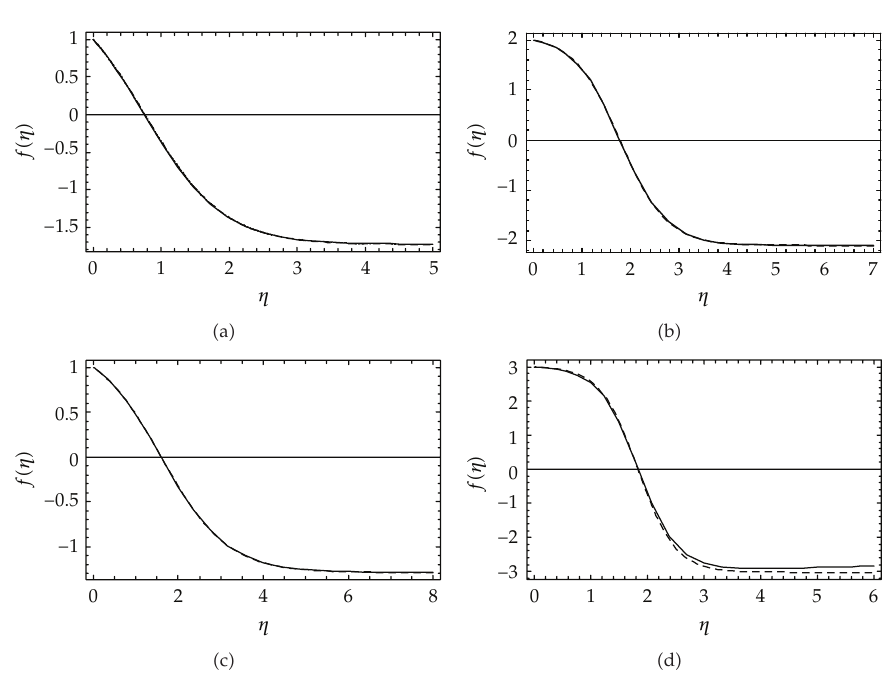
Figure 7: Profiles of the similar stream function f (cid:3) η (cid:4) as a function of η at m (cid:8) − 1 , σ (cid:8) 0 in R 2 for (cid:3) a (cid:4) λ (cid:8) 2 and s (cid:8) 1, (cid:3) b (cid:4) λ (cid:8) 3 and s (cid:8) 2, (cid:3) c (cid:4) λ (cid:8) 4 and s (cid:8) 1, and (cid:3) d (cid:4) λ (cid:8) 5 and s (cid:8) 3, where solid and dashed lines are for ChPDM and G (cid:2) /G -expansion solutions, respectively.